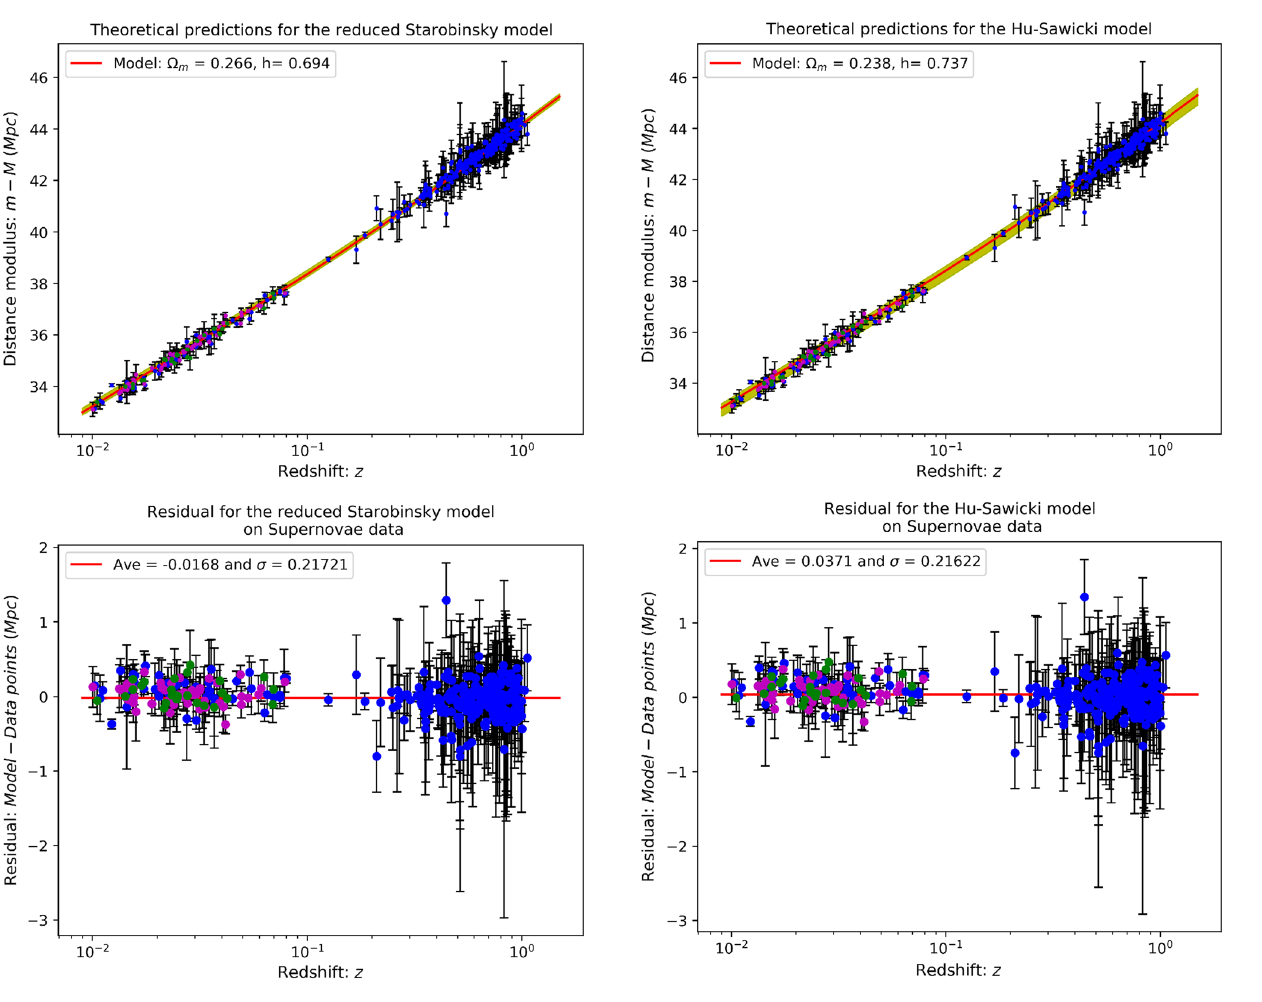
Fig. 7 The reduced Starobinsky model fitted to the Supernovae Type 1A data. With cosmological parameter values calculated by the MCMC simulation as Ω m = 0 . 266 + 0 . 026 − (constrained), and q 0 = − 0 . 697 + 0 . 173 −